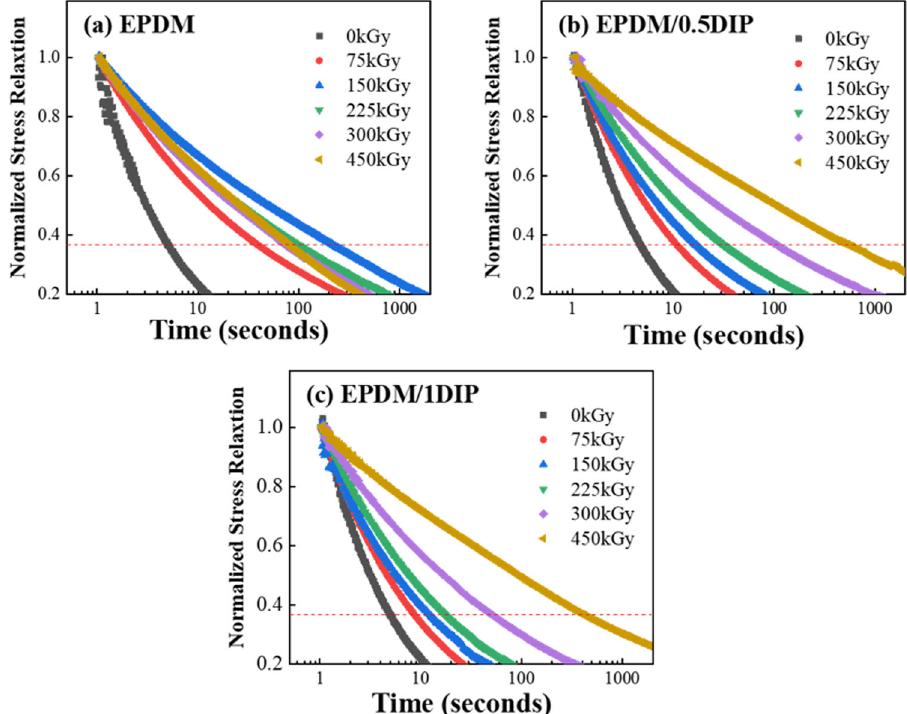
Fig. 5 Stress relaxation curves of the EPDM and EPDM blends at different γ -irradiation doses measured in air at 180 °C. a EPDM, b EPDM/ 0.5DIP blend, c EPDM/1DIP blend.